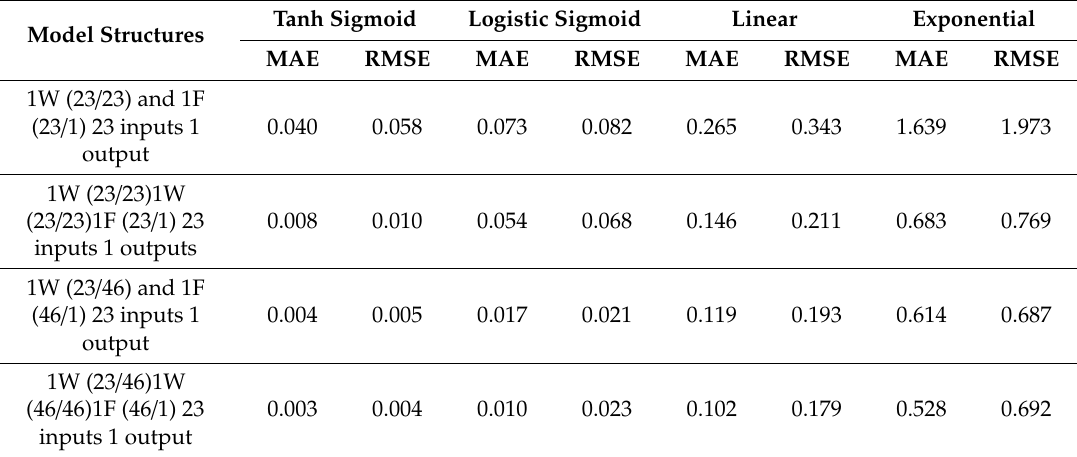
Table 4. Tested mathematical functions at an epoch size of 15,000 with normalized